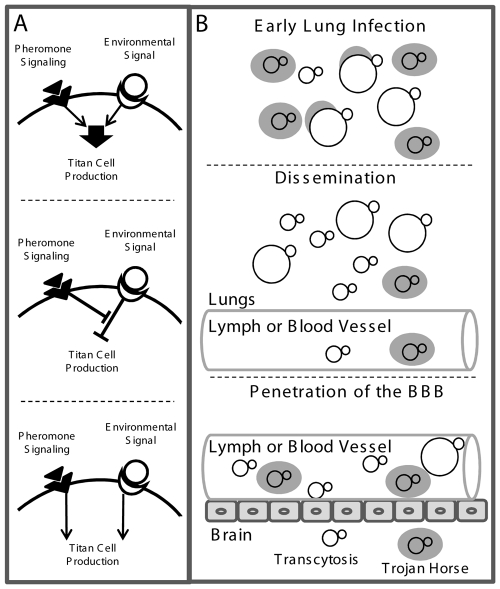
Model of titan cell signal transduction and pathogenesis.
A) Putative pathways involved in titan cell production. Top: Pheromone signaling may enhance an environmental sensing signal leading to titan cell production. Middle: Pheromone signaling may inhibit a negative regulator of titan cell formation. Bottom: Pheromone signaling may act independently of the environmental sensing and/or other pathways leading to titan cells formation. B) The effect of titan cell formation on pathogenesis. Top: Upon initial infection, titan cell production protects a subset of cells from phagocytosis and killing, to establish the infection. Middle:
C. neoformans cells disseminate from the lungs either as free cells or inside host phagocytes. Bottom: Phagocytosis is required for efficient penetration of the blood-brain barrier. Cryptococcal cells may enter the brain by transcytosis, or as a “Trojan horse” inside of host phagocytes. Over-production of titan cells reduces blood-brain barrier penetration as a result of decreased phagocytosis.